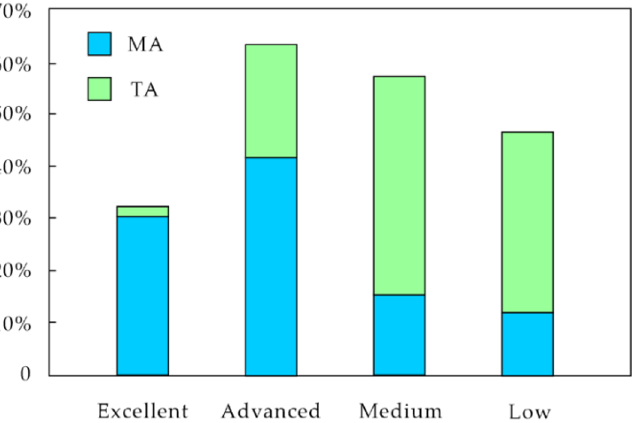
Figure 5. Area proportion of cultivated land in the comprehensive quality in different grades.